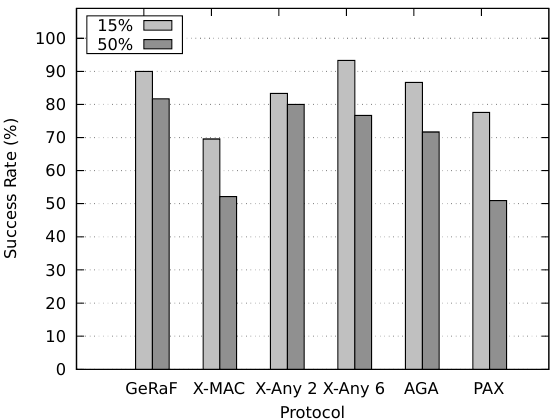
Figure 13. Packet delivery success rate for concurrent flows transmitted in non-persistent mode, for data packet durations t data = 50% t cycle and t data = 15% t cycle , SD = 650 m.